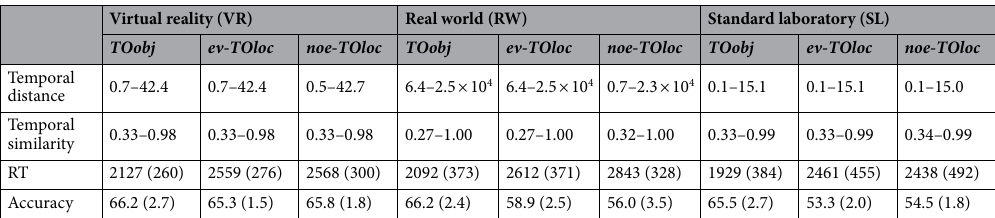
Table 2. Temporal-order discrimination task. Temporal characteristics of the to-be-judged pairs of events during the temporal-order task and the average behavioral performance for the different conditions (TOobj, ev-TOloc, noe-TOloc) and encoding contexts (VR, RW, SL). Temporal distance : Time between the occurrence of the two events during encoding (range, in minutes); Temporal similarity: Similarity values computed according to the SIMPLE model (range, in similarity units [0–1], see “Methods” section). RT: Mean reaction times during retrieval (in ms, with standard error); Accuracy: Mean accuracy during retrieval (in %, with standard